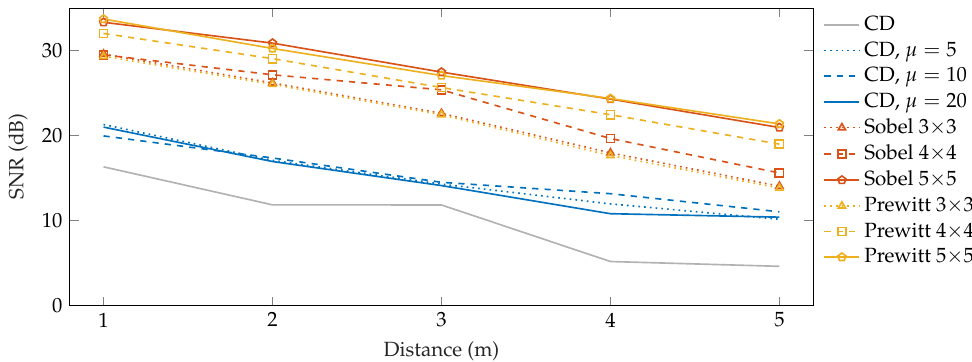
Figure 10. SNR results of the walk localization depending on the distance from the sensing fiber.